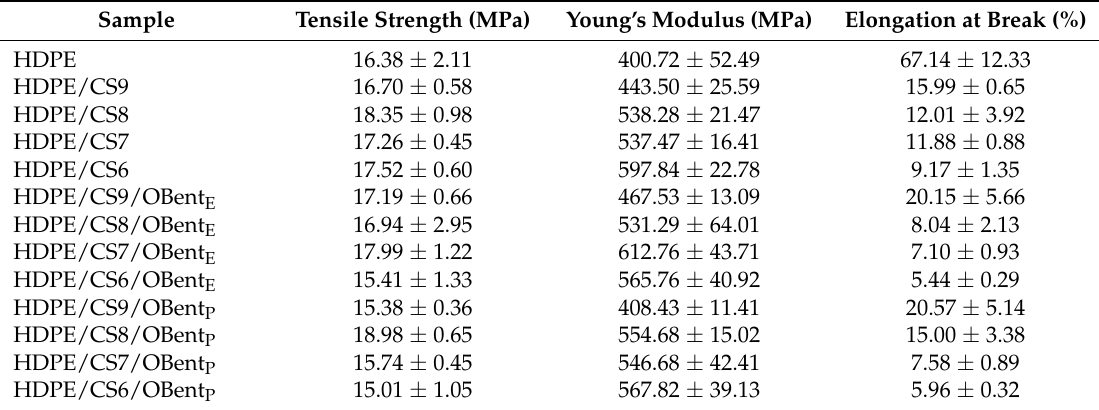
Table 4. Tensile properties of HDPE, HDPE/CS, and HDPE/CS/OBent formulations.